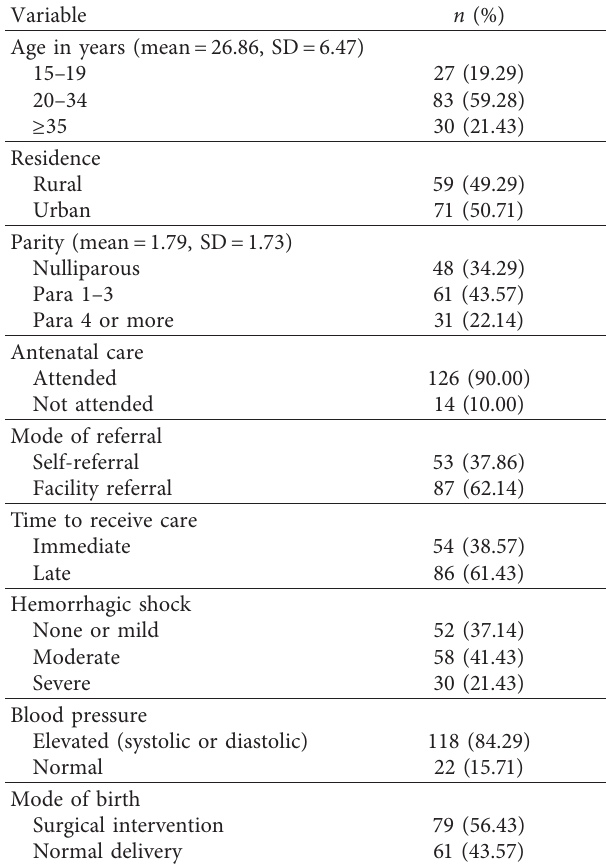
Table 1: Baseline and clinical characteristics on admission of the subjects, DRRH, Tanzania, January 2016 ( n � 140).